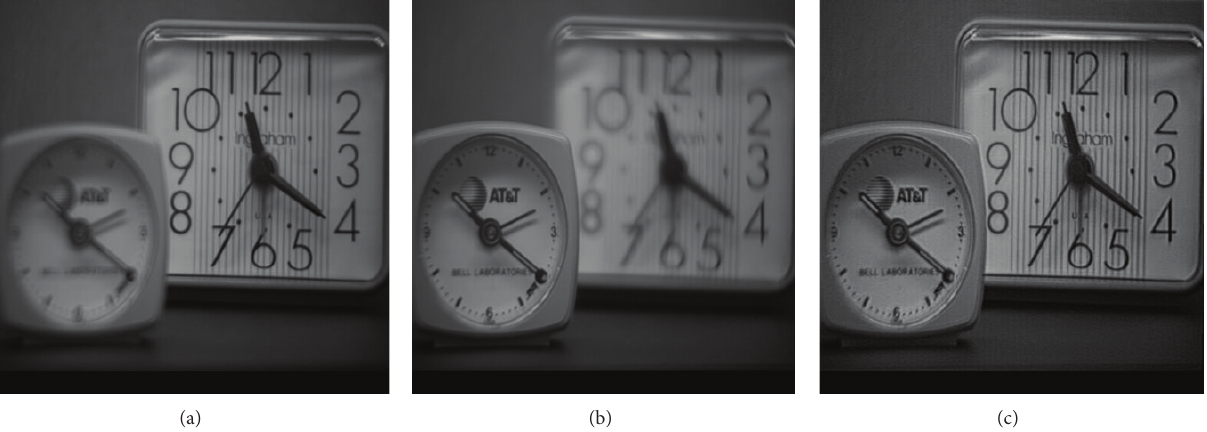
Figure 5: ((a), (b)) Two partially focused images (focused on different targets), (c) image generated by the proposed approach, which illustrates that the fused image extracts more information from the original images. Input sequence is courtesy of Adu and Wang.